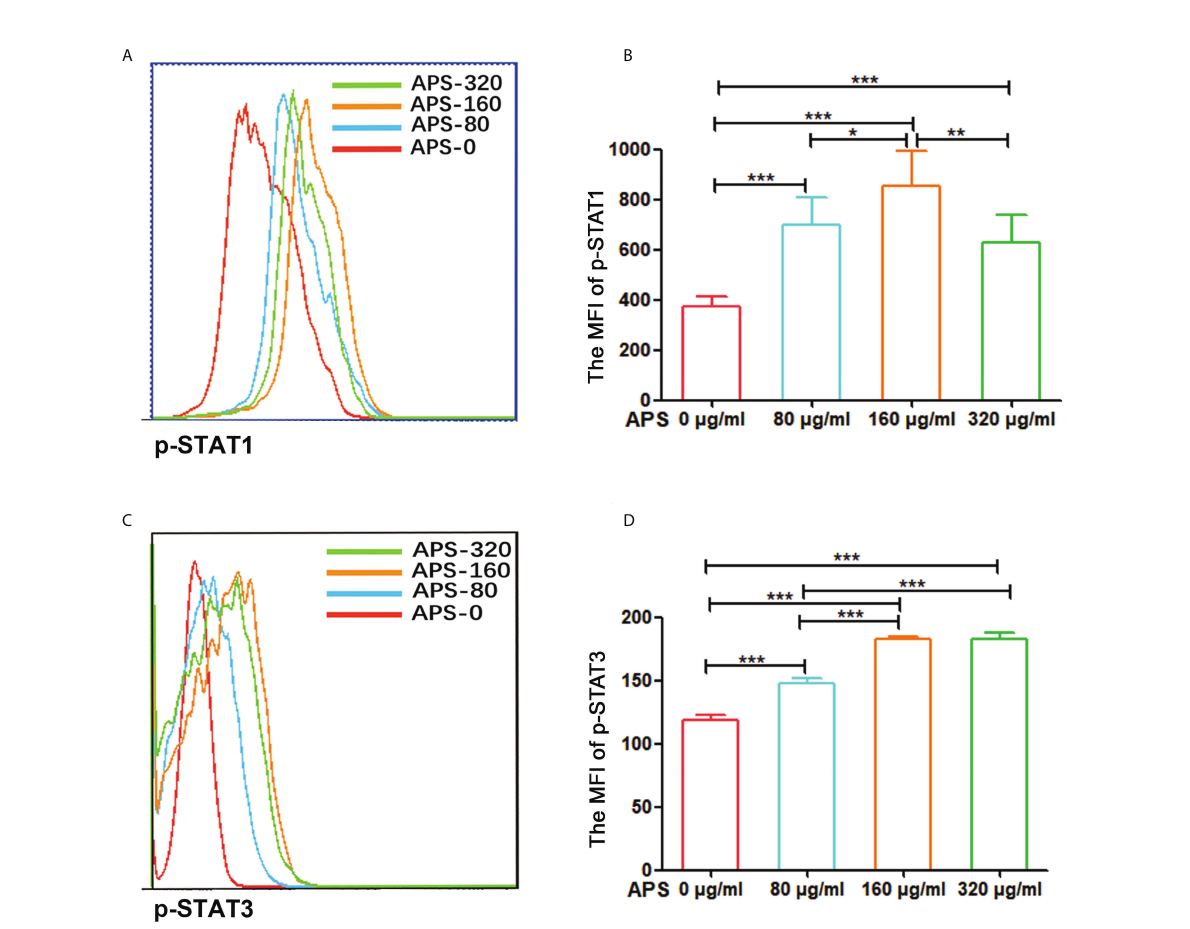
FIGURE 8 APS up-regulated STAT1 and STAT3 signaling pathways in MDSC. MDSC isolated from tumor-bearing mice were treated with APS at a concentration of 0, 80, 160 and 320 m g/ml for 12 h. (A, C) One representative result from each experiment is shown. (B) The MFI of p-STAT1 in MDSC (***p<0.001, **p<0.01, *p<0.05). (D) The MFI of p-STAT3 in MDSC (***p<0.001). n=6, Data are expressed by mean ±